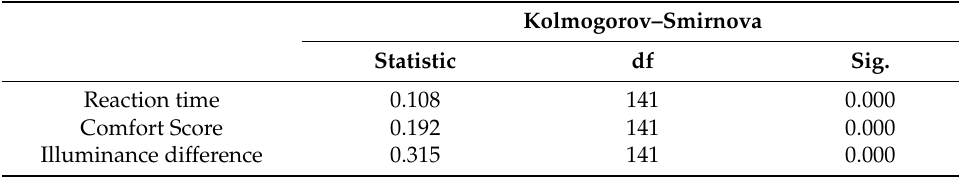
Table 5. Test for normality under decreasing